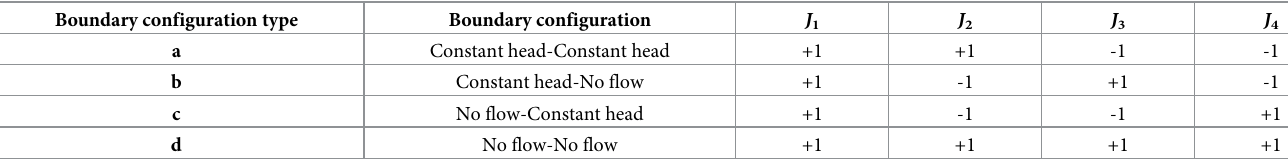
Table 1. Values of parameters J 1 to J 4 in Eq (8) for various boundary